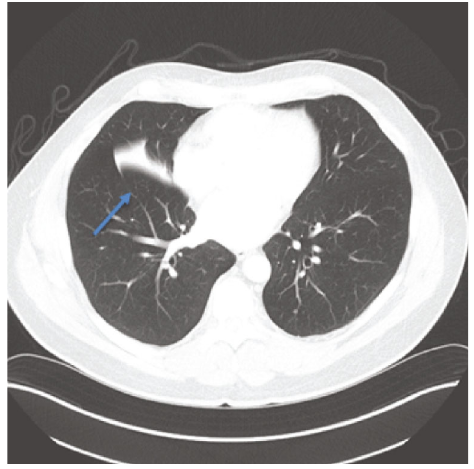
Figure 4: CT chest, axial view: blue arrow denoting an opacity throughout much of the right middle